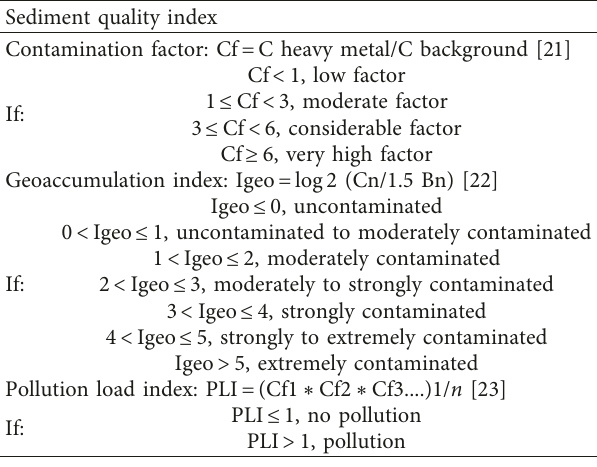
Table 3: Pollutants indicators: sediment quality indexes. Sediment quality